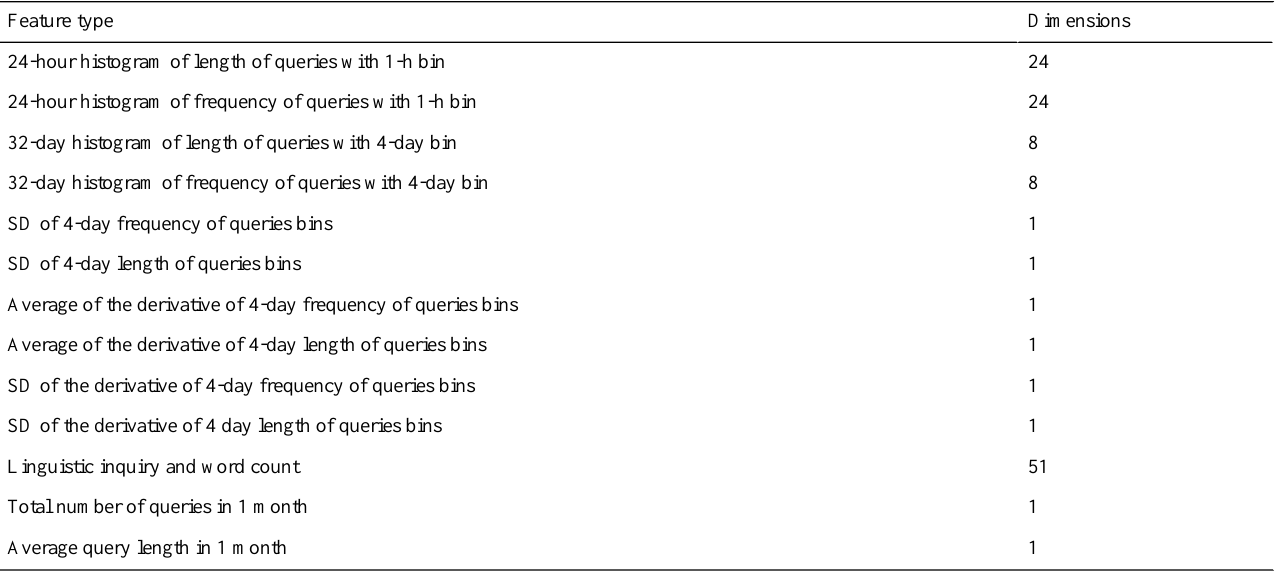
Table 1. Feature categories along with the dimensionality of each feature